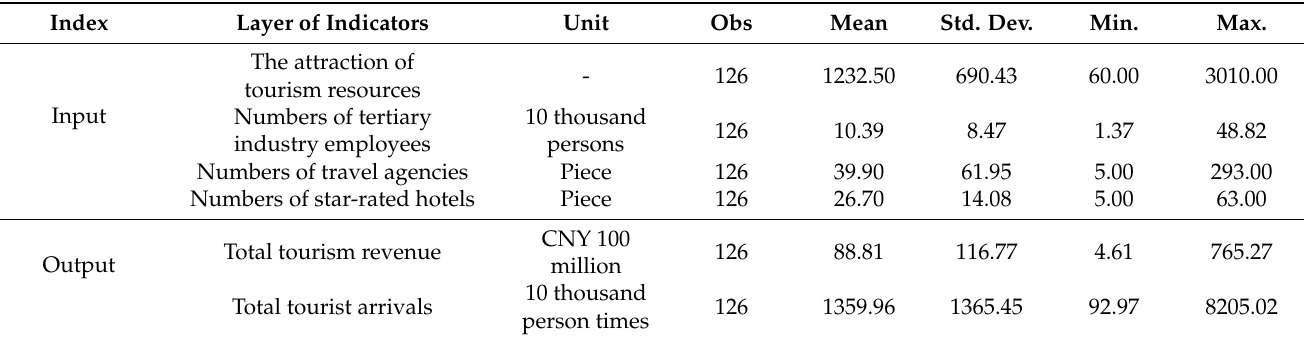
Table 1. The index evaluation system of tourism efficiency and its descriptive statistics in Gansu